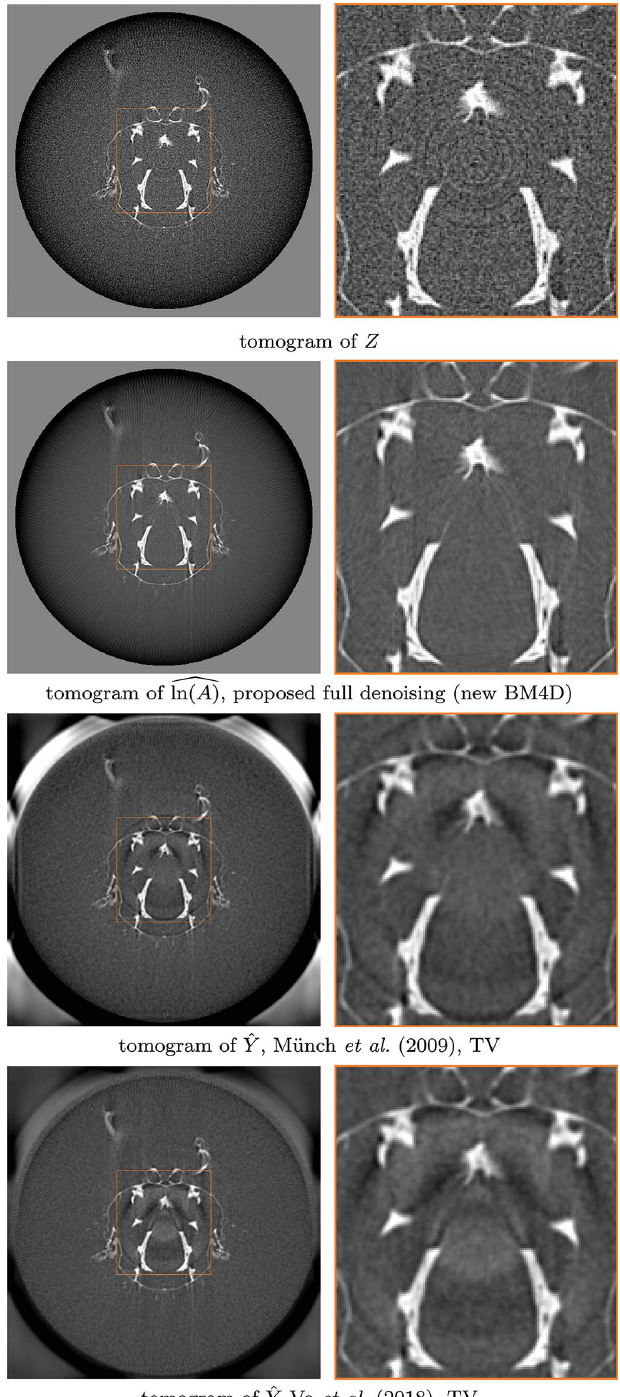
Figure 8 Comparison of fully denoised tomograms of Fly . Top-to-bottom: tomogram reconstructed from a noisy sinogram of the stack of projections Z (4), from the estimate of stack of underlying projections d ln ð A Þ ln ð A Þ with proposed procedure with FBP reconstruction, and tomograms of the estimates for streak-free stacks ^ YY of Mu¨nch et al. (2009) with TV reconstruction, and ^ YY of Vo et al. (2018) with TV reconstruction. TV regularization was tuned visually, balancing residual noise and smoothing of signal. Compared with the reference methods, the proposed procedure manages to remove most noise without creating shadowlike artifacts common to Mu¨nch et al. (2009) and Vo et al.